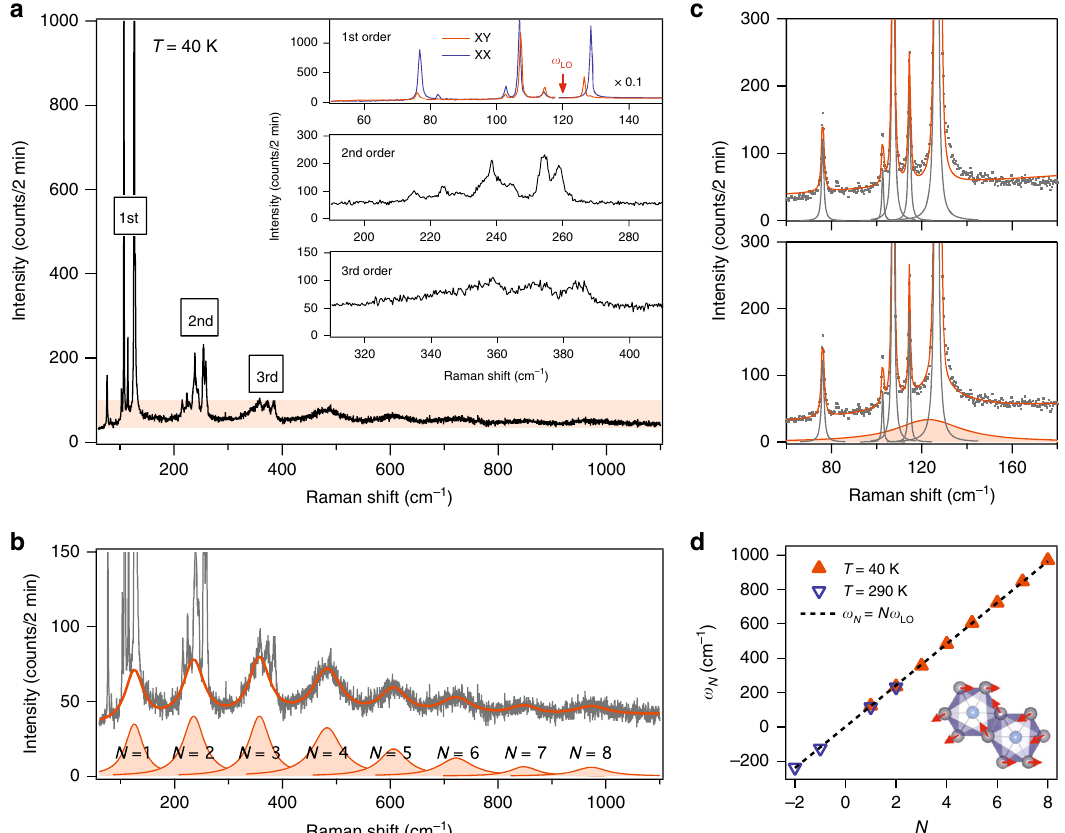
Fig. 2 Polaronic character of exciton dynamics in bilayer CrI 3 . a Raman spectrum of bilayer CrI 3 acquired in the linearly crossed polarization channel at 40 K using a 633 nm laser. Insets show 1st-order single-phonon modes (linear parallel/crossed, i.e., XX/XY, channel in blue/red), 2nd-order two-phonon modes, and 3rd order three-phonon modes. The red arrow indicates the Raman-inactive longitudinal optical (LO) phonon frequency of importance, ω LO . The spectral intensities in the frequency range above 118 cm − 1 are scaled by a factor of 0.1. b Zoom-in of the orange shaded area in the spectrum in a . The solid orange line overlaid on the raw data is the fi t to the periodic pattern in the Raman spectrum with a sum of eight Lorentzian pro fi les indexed from N = 1 (cid:4) (cid:5) P 2 A N Γ N 8 (cid:4) (cid:5) þ C . c Fit of the Raman spectrum over the 1st-order spectral range without (upper panel) and 2 to N = 8 and a constant background, i.e., N ¼ 1 2 ω (cid:2) ω N ð Þ 2 þ Γ N 2 with (lower panel) the consideration of the N = 1 broad mode (shaded Lorentzian pro fi le in the lower panel). d Plot of the fi tted central frequency ( ω N ) of the N th Lorentzian pro fi le in data taken at 40 K (solid orange triangle) and 290 K (hollow blue triangle). Dashed line is a linear fi t ( ω N ¼ N ω LO ) to the plot that yields a slot of ω LO ¼ 120 : 6 ± 0 : 9 cm − 1 . Inset shows the atomic displacement of the LO phonon